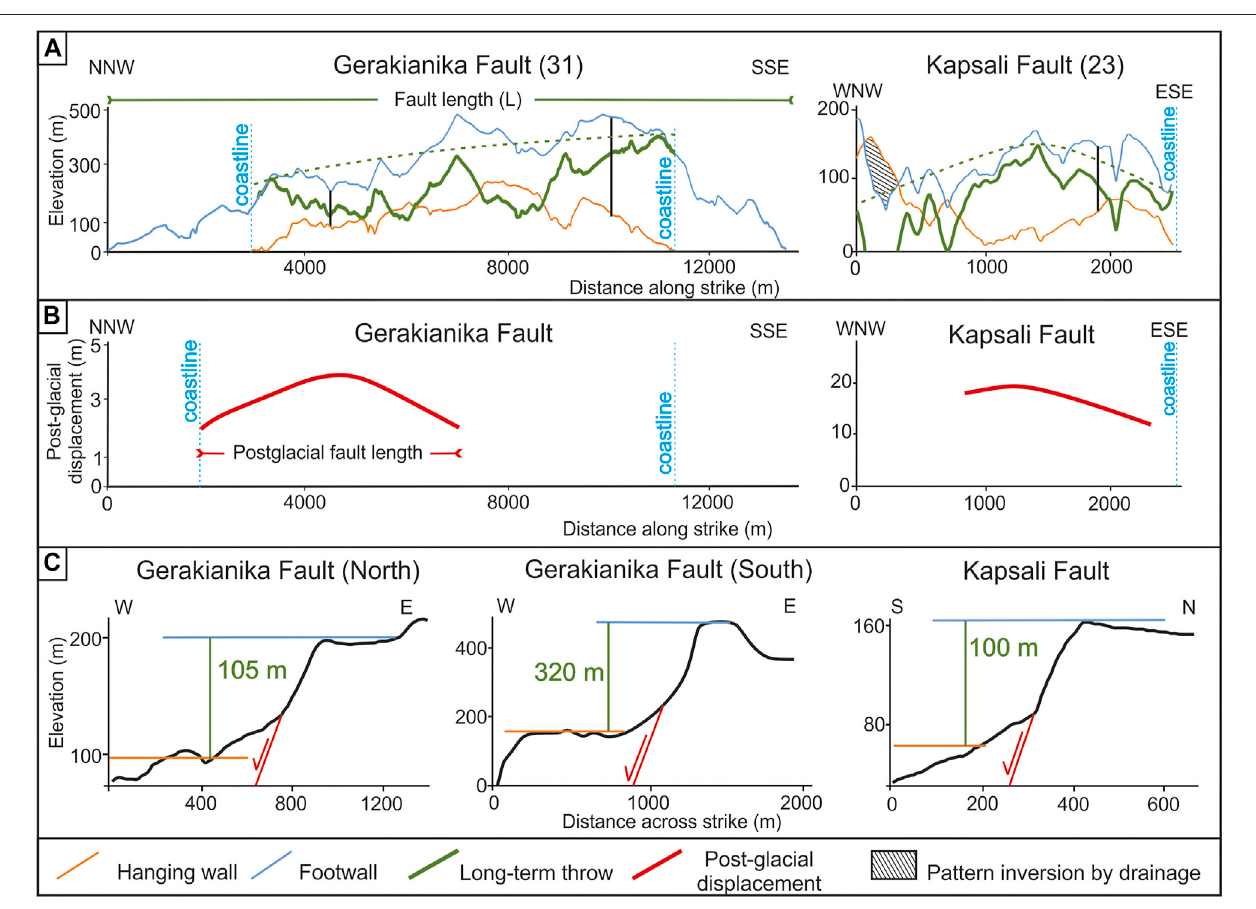
FIGURE 3 | Displacement accumulation pro fi les along two faults in Kythira over the last 0.7 – 3 Ma (A) and 16 ± 2 ka (B) : The Gerakianika Fault (ID (cid:1) 31 in Table 1 ) from Group A and the Kapsali Fault (ID (cid:1) 23 in Table 1 ) from Group C. Across-strike pro fi les on the same faults over the last 0.7 – 3 Ma (C) .